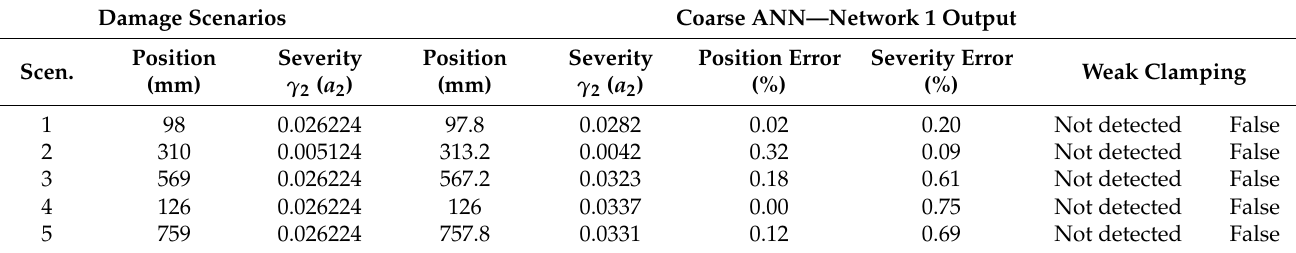
Table 13. Results obtained using the ANN—Network 1.